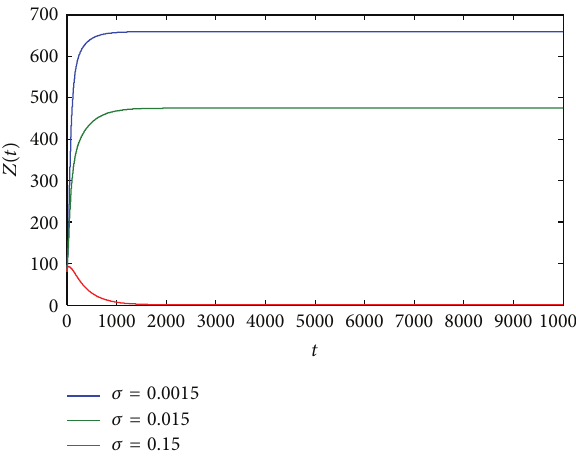
Figure 6: Size of the spreader class over time under different stifling rate 𝜎 with 𝜀 = 3 , 𝑘 1 = 0.00005 , 𝑘 2 = 0.002 , 𝑘 3 = 0.004 , 𝑘 4 = 0.0002 , 𝛽 = 0.00015 , 𝜇 = 0.00005 , 𝛼 = 0.015 , 𝜃 = 0.0001 , and 𝜆 = 0.6